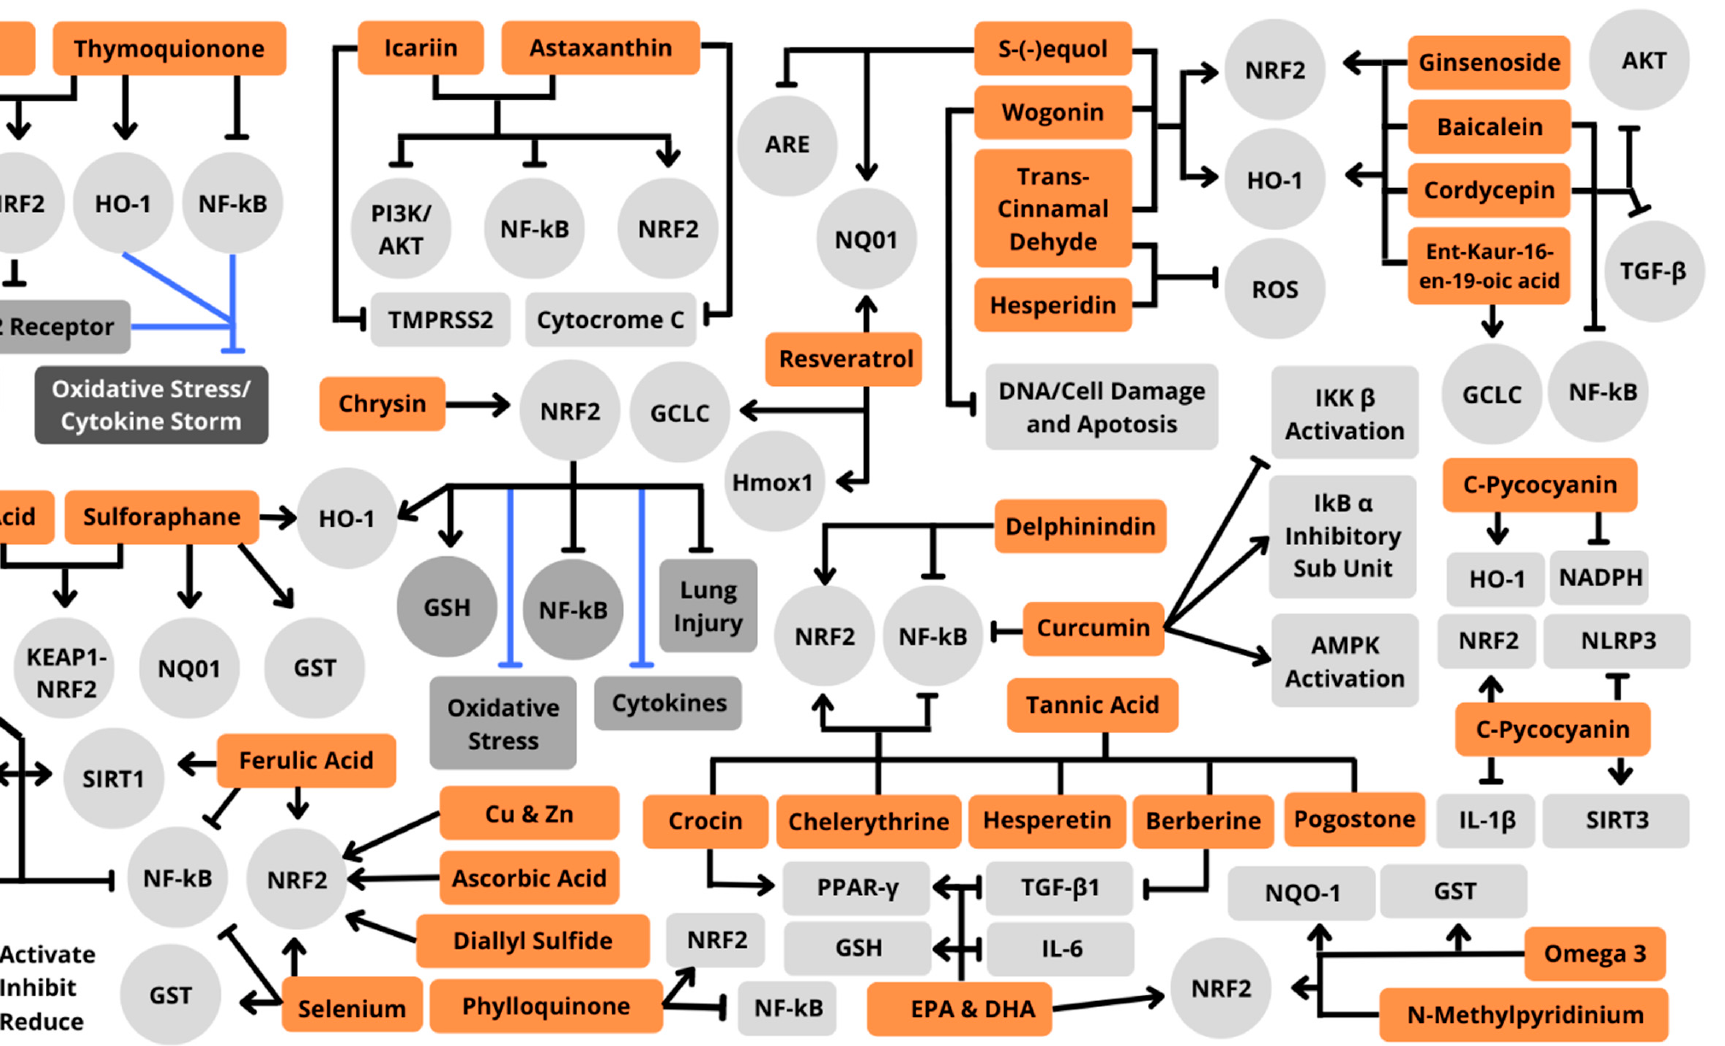
Figure 9. Mechanism of natural antioxidant compounds in Nrf2 activation.